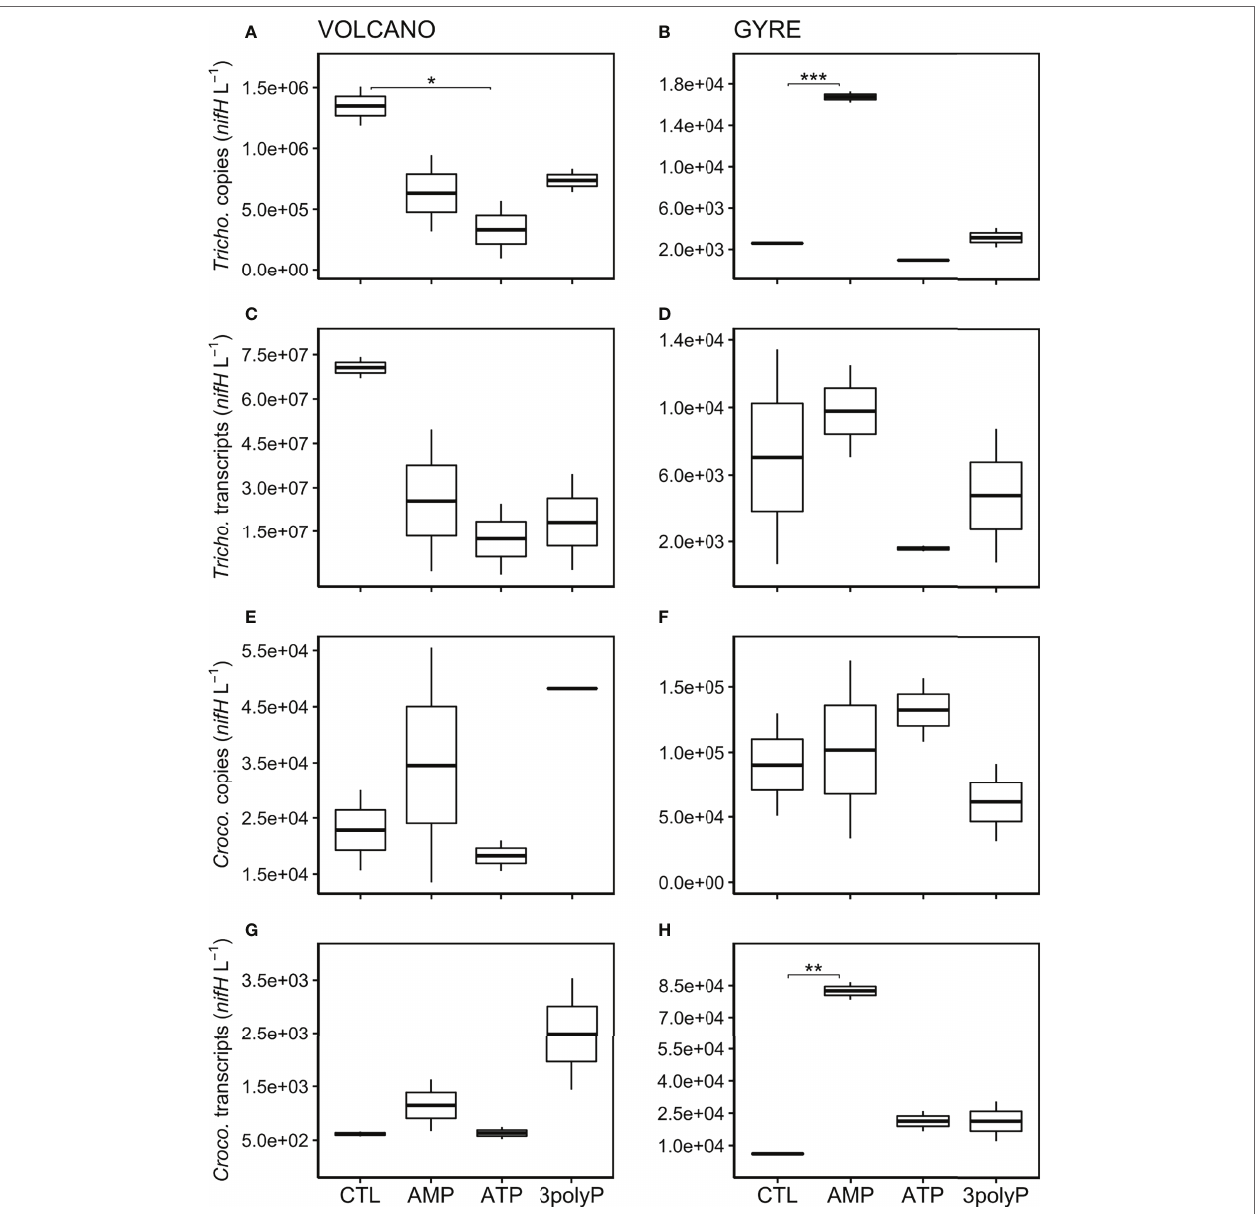
FIGURE 2 | Abundance of Trichodesmium and Crocosphaera nifH copies and transcripts after incubations. Boxplots represent averaged nifH copies (DNA) and transcripts (cDNA) abundances (L −1 ) from qPCR measurements in triplicate from each treatment duplicate for Trichodesmium at the volcano (A, C) and at the gyre station (B, D) , and Crocosphaera at the volcano (E, G) and at the gyre station (F, H) , respectively. Significant differences in nifH copies or transcripts between the control and the DOP treatments were tested with the Dunnett’s Test and represented by the horizontal lines with significant codes (***p<0.001, **p<0.01,